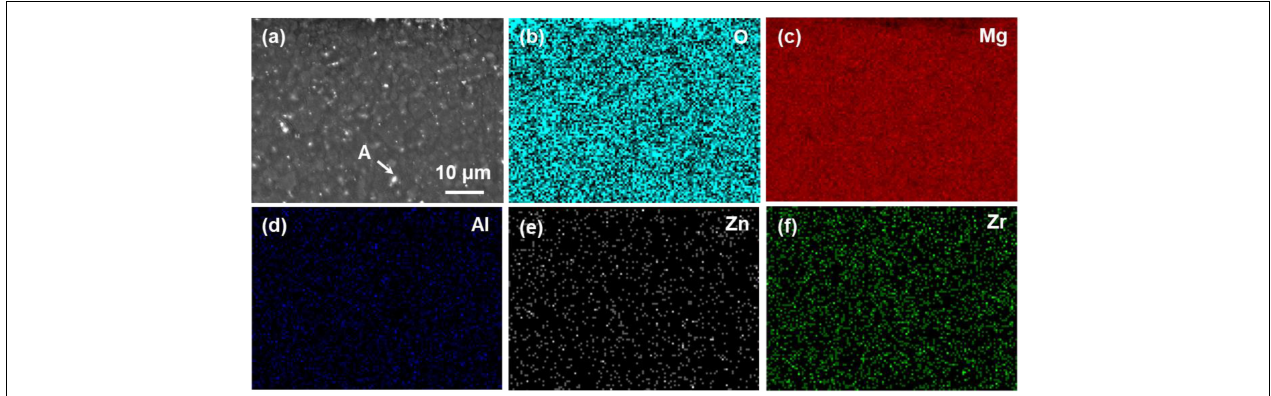
FIGURE 4 | EM-EDS mapping shows (a) the ZrO 2 particles embedded in matrix (b–f) color mapping of elements O, Mg, Al, Zn, and Zr of the SZ-center in FSPed AZ31/ZrO 2 composite (Z3-3P Specimen).